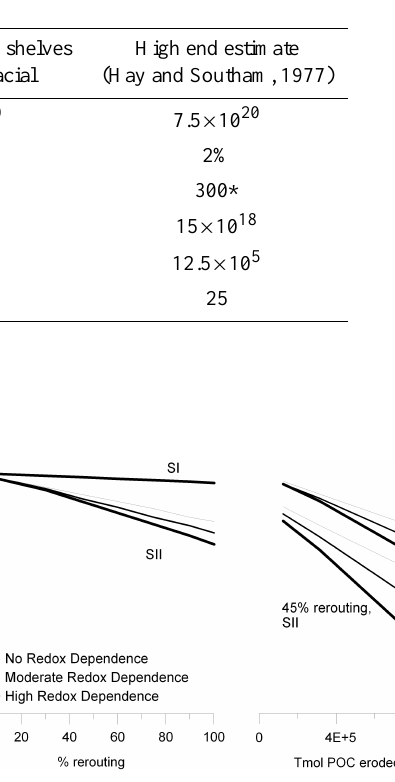
Table 1. Estimates of flux of organic matter eroded from exposed shelves and supplied to the ocean during sea level low stand of glacial periods.